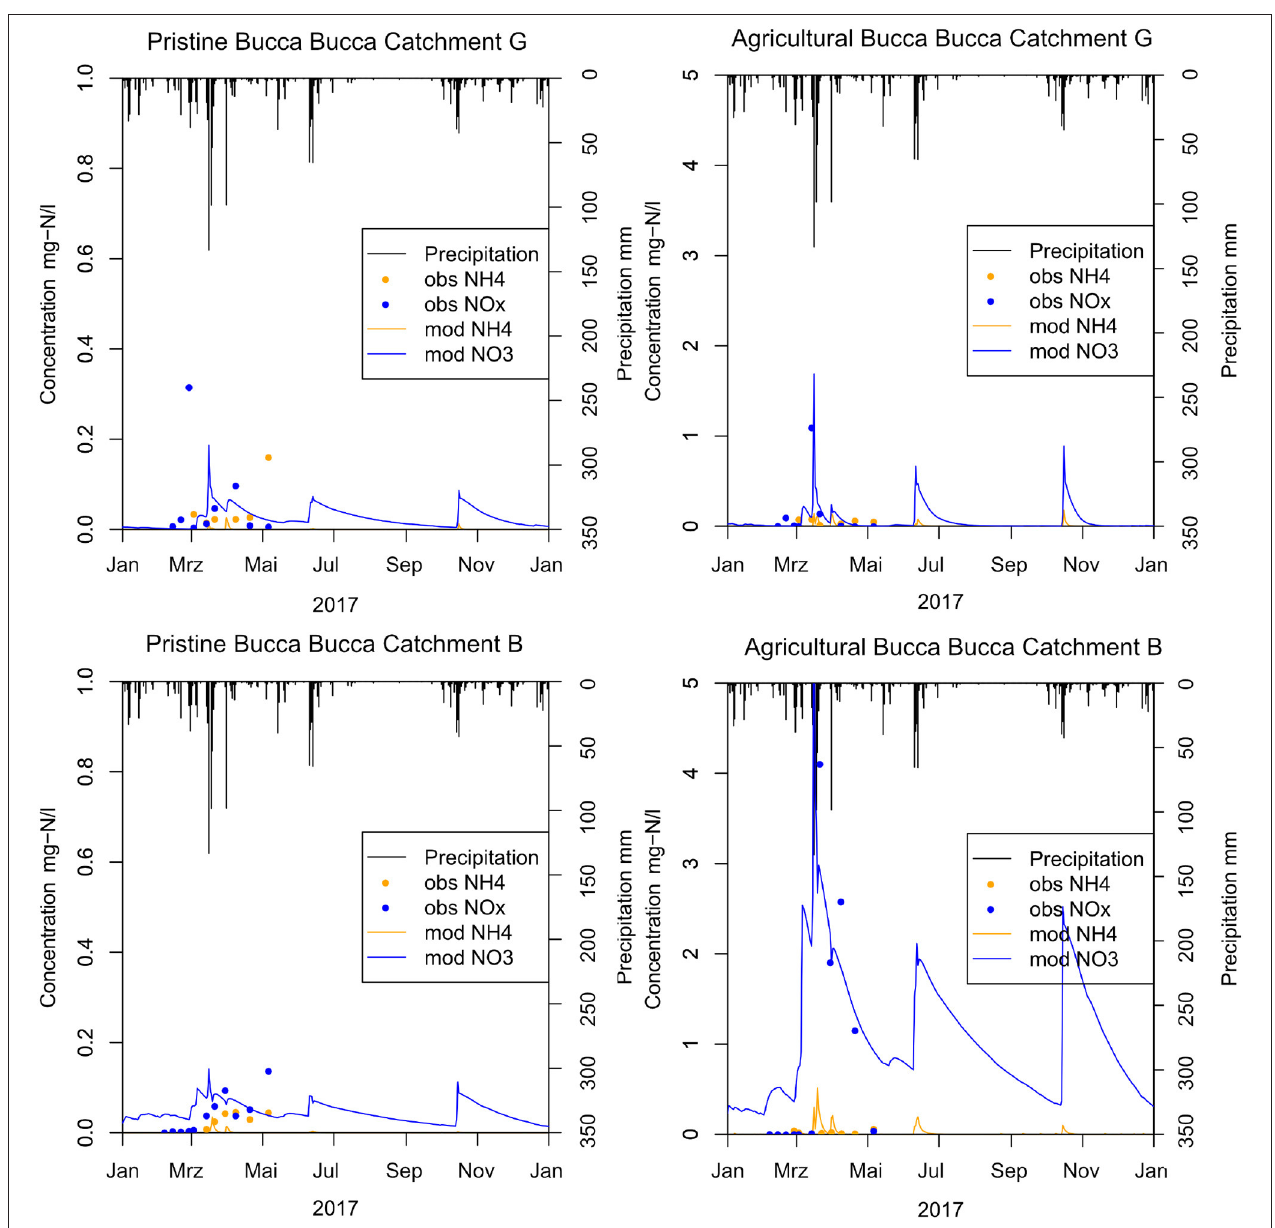
FIGURE 4 | Modeled calibration results (mod) compared with weekly observed creek water measurements (obs) from February until May 2017 showing explanatory creek G (top) and B (bottom) for pristine (c) catchments (left) with 0% horticulture and agricultural (t) catchments (right) with horticultural coverage. The treatment catchment at creek G has 2.7% horticultural coverage and creek B has 59.1%